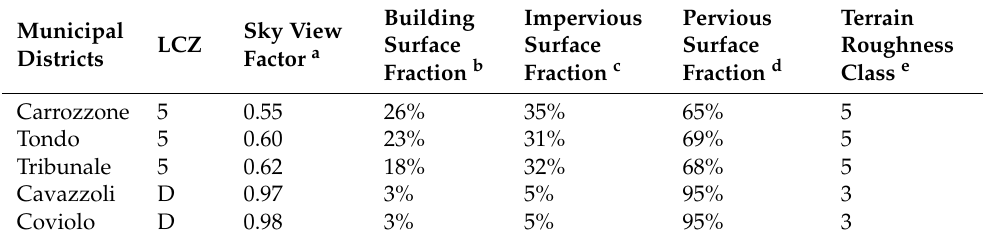
Table 4. Chosen areas and LCZ parameters calculation.